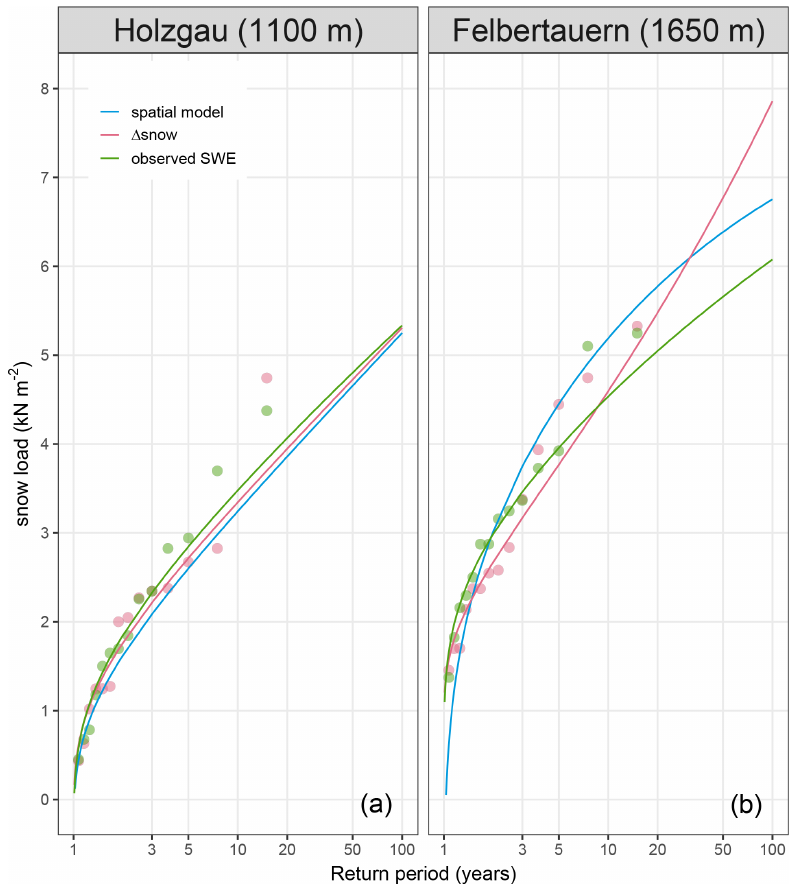
Figure C2. Return levels of snow load at stations Holzgau (left) and Felbertauern (right). Return periods in years are shown on the logarithmic x axis. The blue line shows return levels obtained with the spatial extreme value model, pink bullets and lines depict yearly maxima and the GEV fit of SWE values modeled from daily snow depths with the (cid:49) SNOW model, and green colors represent yearly SWE maxima and the corresponding GEV fit from (ca. weekly)